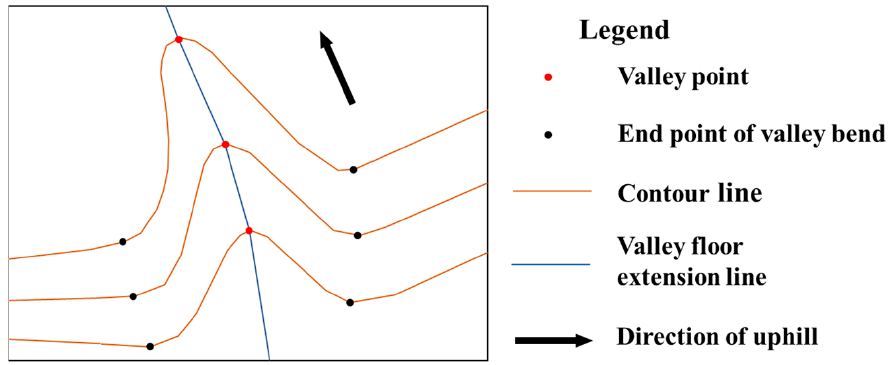
Figure 4. Valley bend, valley point, and end point of the valley bend.